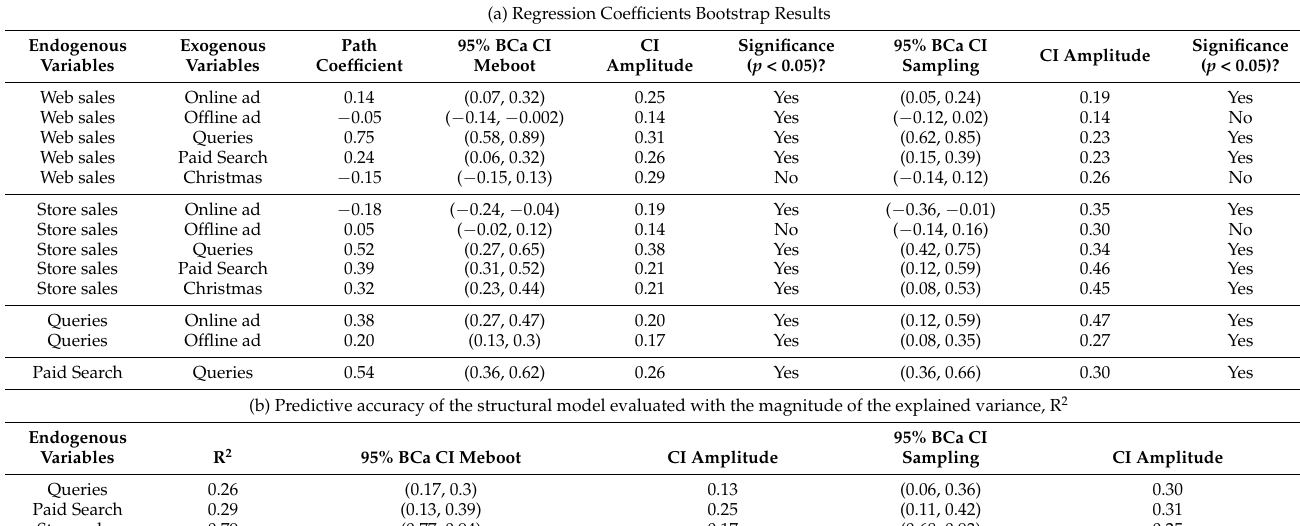
Table 4. Evaluation of the structural model. ( a ) The model’s regression coefficients and their significance based on meboot and sampling bootstrapping. ( b ) The model’s predictive accuracy based on meboot and sampling bootstrapping. (a) Regression Coefficients Bootstrap